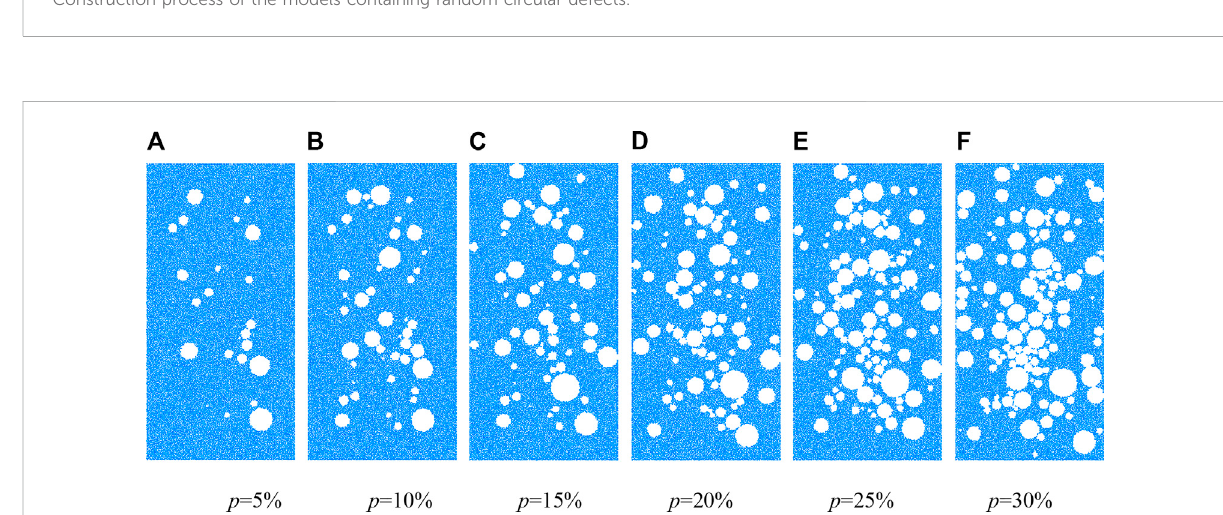
Numerical models containing random circular defects under different porosities (Group 3#, m = 1.9). (A) p = 5% (B) p = 10% (C) p = 15% (D) p = 20% (E) p = 25% (F) p =